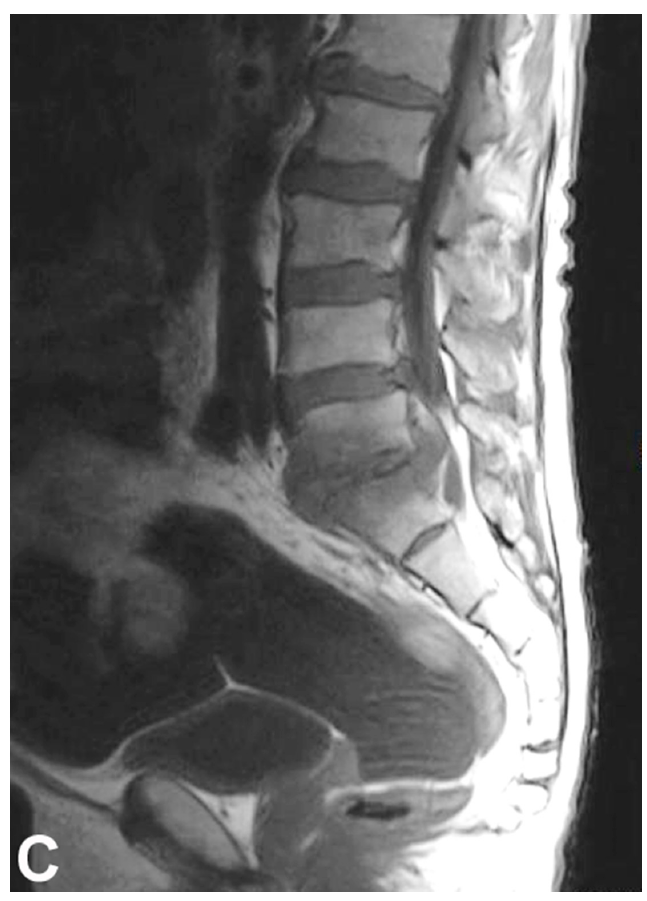
Figure 1. A 64-year-old man with HBV-related hepatic cirrhosis, and L5-S1 MRSA spondylodiscitis. ( A ) PET/CT shows diffuse uptake at the L5-S1 level (SUV, 4.06); ( B ) Sagittal CT scans show complete destruction of the L5-S1 intervertebral disc and erosion of L5 and S1 vertebra; ( C ) T1-weighted magnetic resonance (MR) imaging shows abscess formation at the L5-S1 level. He was treated with antibiotics and surgical decompression.